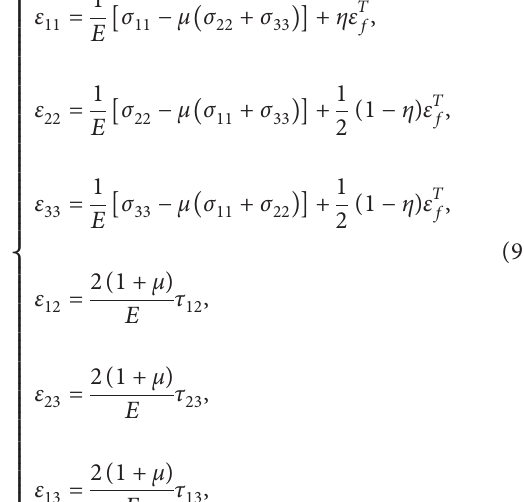
Figure 1: Local coordinate